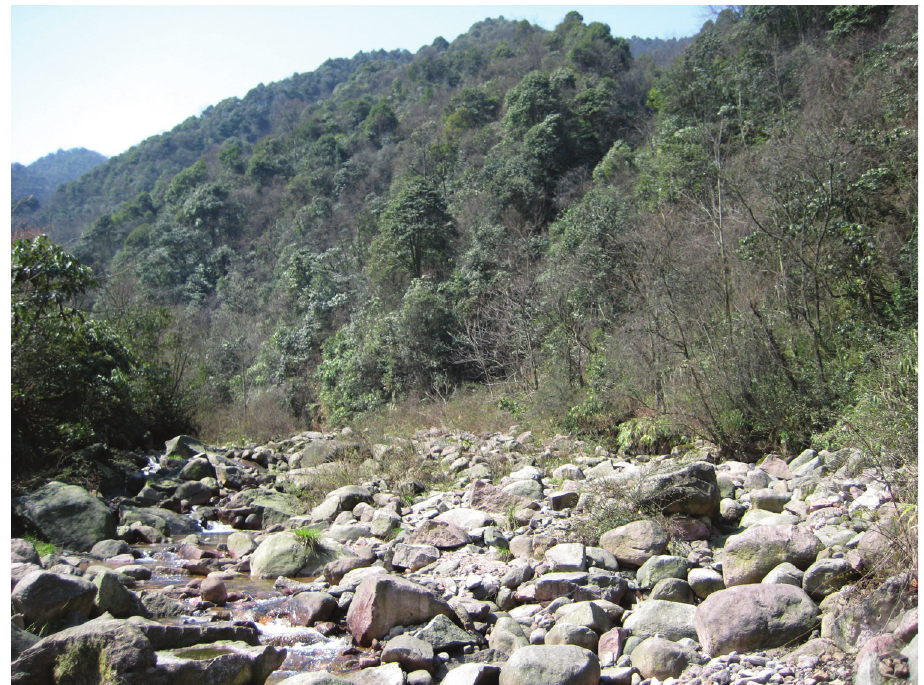
Figure 27. Harutaeographa shui , type locality , China, Sichuan near